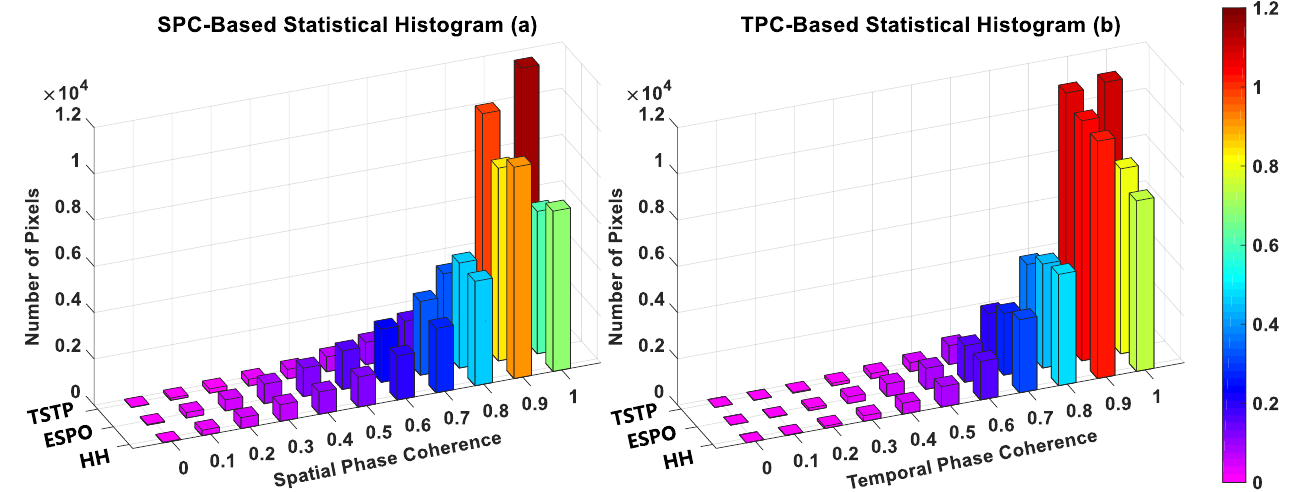
Figure 13. Estimated coherence histograms of the marked natural area by the red irregular boxes in Figure 9a under different methods (i.e., HH, ESPO, and proposed TSTP). ( a ) SPC. ( b ) TPC. Under the premise of the same number of candidate pixels, if this method is considered a better one, it can be seen from the histogram that the number of the highly coherent pixels increases, and accordingly the number of the lowly coherent pixels decreases.